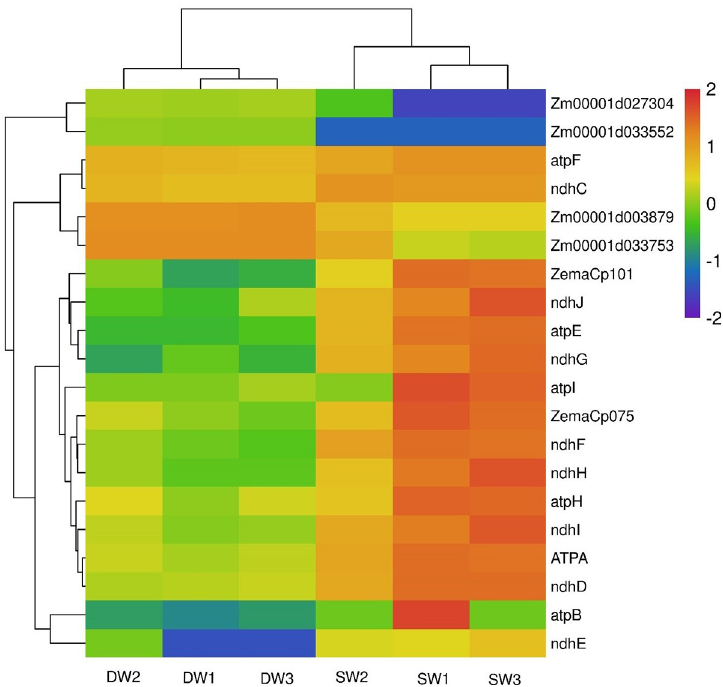
Fig 6. Heat map of oxidative phosphorylation pathway gene expression. SW refers to stable soil moisture content treatment, DW refers to alternately dry and wet treatment, and the number after that indicates the sample number.